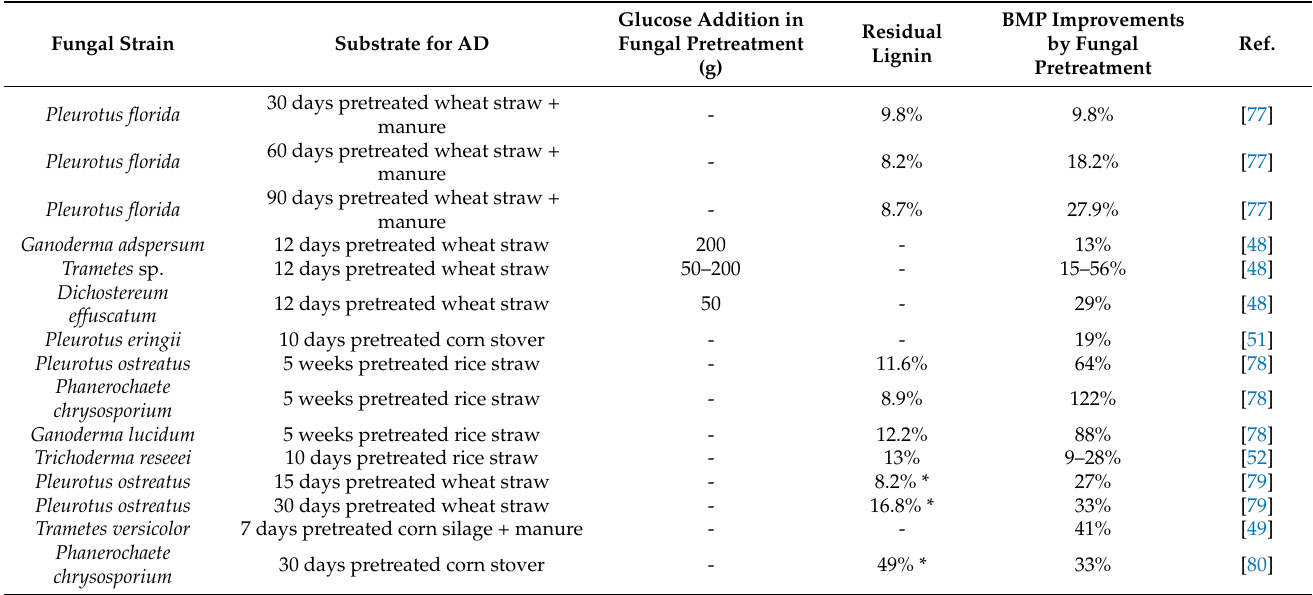
Table 5. Different fungal strains used in delignification of agricultural residues and effects of pretreatments on biogas production (AD = anaerobic digestion; BMP = biochemical methane